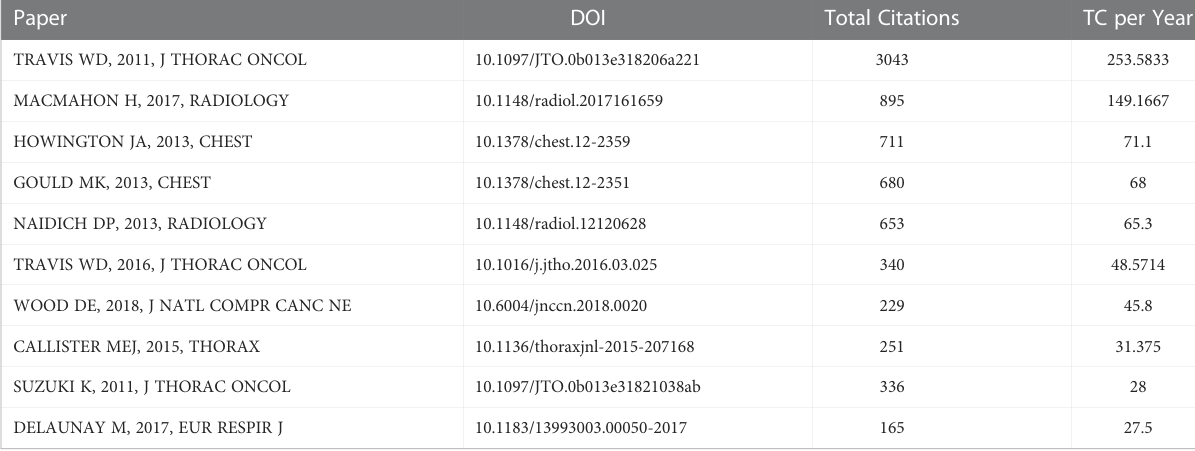
TABLE 1 The top ten articles with the most total